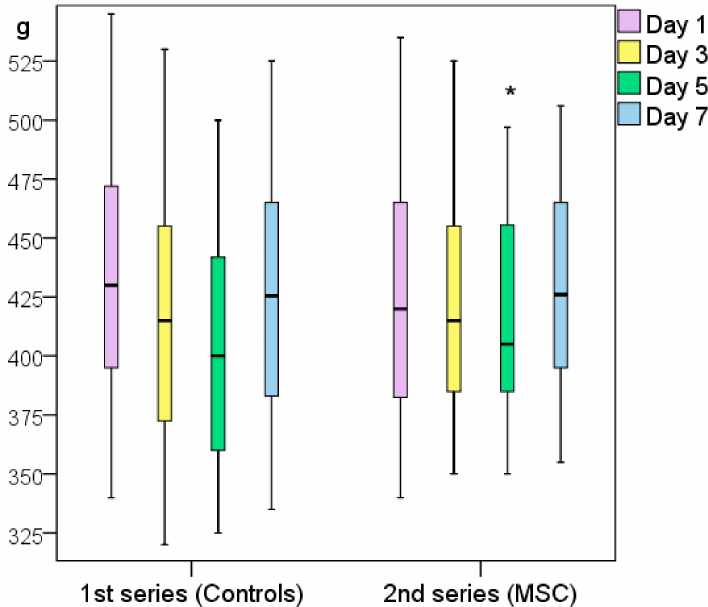
Figure 5. Weight changes of the two experimental series of rats (first series, Control_0 and Con- trol_NaCl groups; second series, MSC and Control_sc groups). Note: * difference between groups at p < 0.05 (Mann–Whitney U-test).